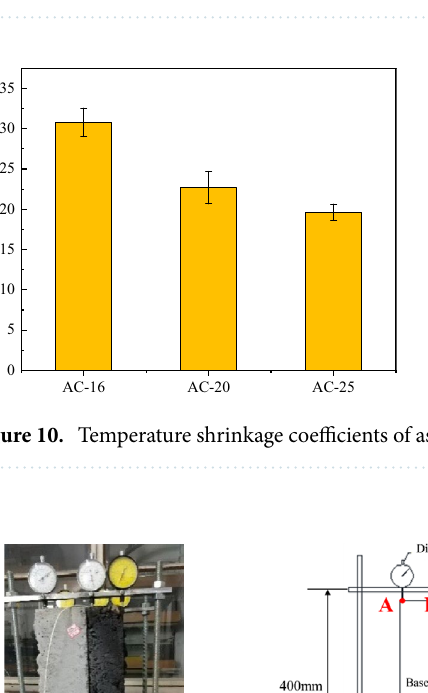
Figure 9. Temperature shrinkage coefficient test setup for asphalt concrete.